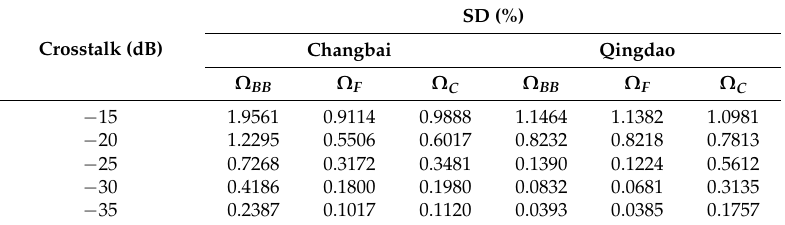
Table 12. SD ( σ SD ) under the condition of